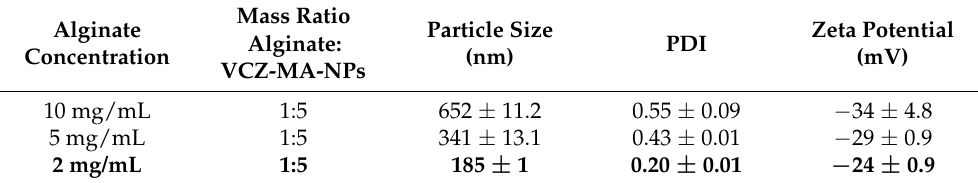
Table 6. Optimization data of